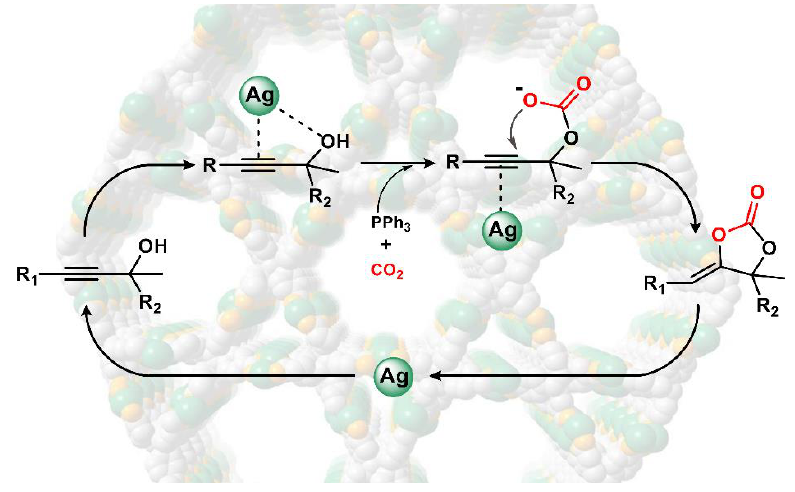
Figure 7. Plausible mechanism for the carboxylative cyclization from propargylic alcohols to cyclic carbonates with CO 2 catalyzed by 1 .